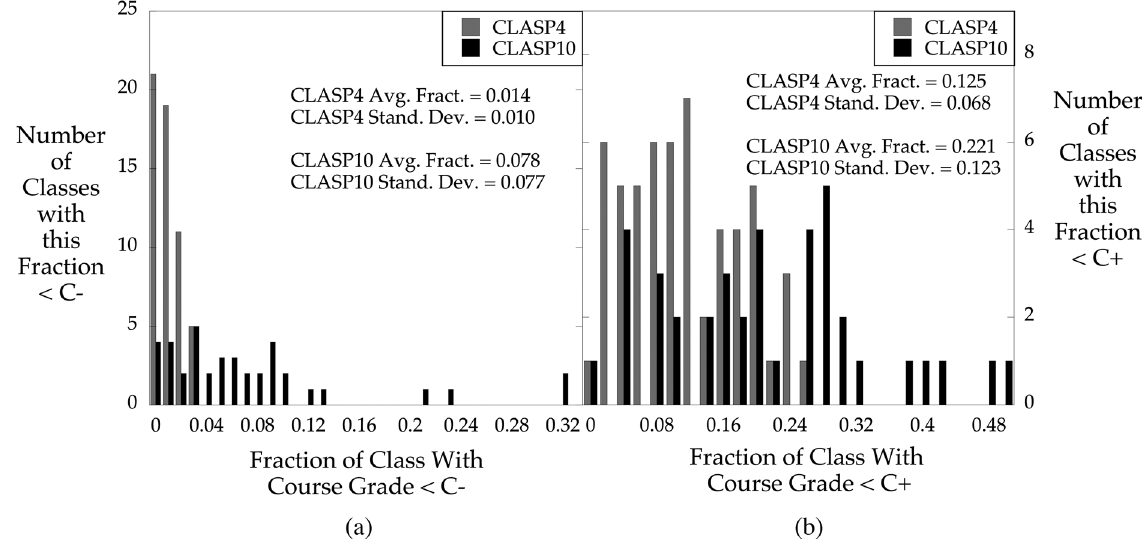
FIG. 5. (a) Histogram showing how classes (categorized by grade scale CLASP4 or CLASP10) are distributed with respect to the fraction of students with course grade < C − . CLASP10 graded classes had a much larger variation in this fraction, extending from 0 to over 0.3. (b) Same as part (a) except the class fractions are for students with course grade < C þ . The higher cutoff is used to remove possible “ floor ” effects (both grade scales had classes in the lowest bin but neither had a class with zero grades less than C þ ). The variation of this fraction is also larger for CLASP10 than for